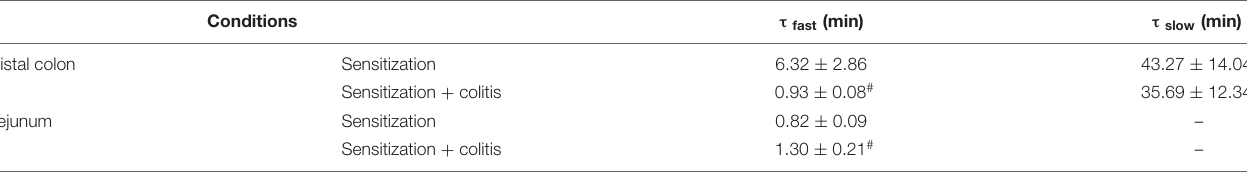
TABLE 4 | Kinetics of the carbachol response.